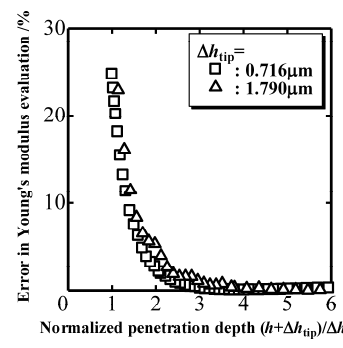
Figure A4. Error in Young’s modulus evaluation with a truncated conical indenter as a function of normalized penetration depth ( h + Δ h tip )/ Δ h tip .